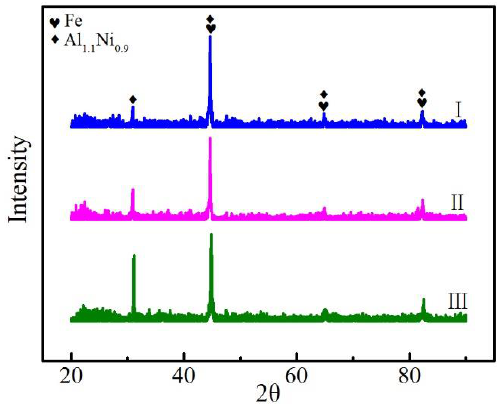
Figure 5. XRD results: I (CC 0.2 m/min), II (CC 0.3 m/min) and III (PC 0.2 m/min).